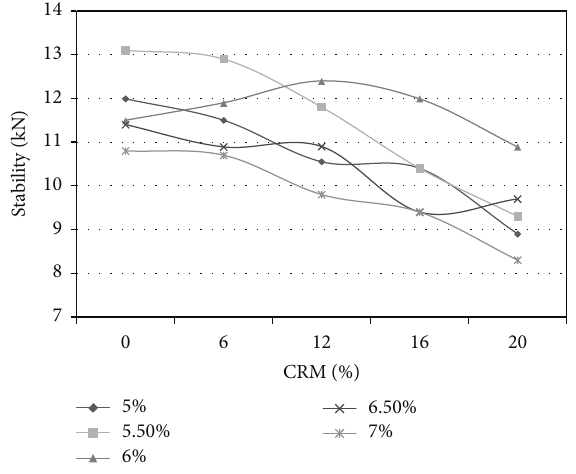
Figure 3: Flow results versus binder content.